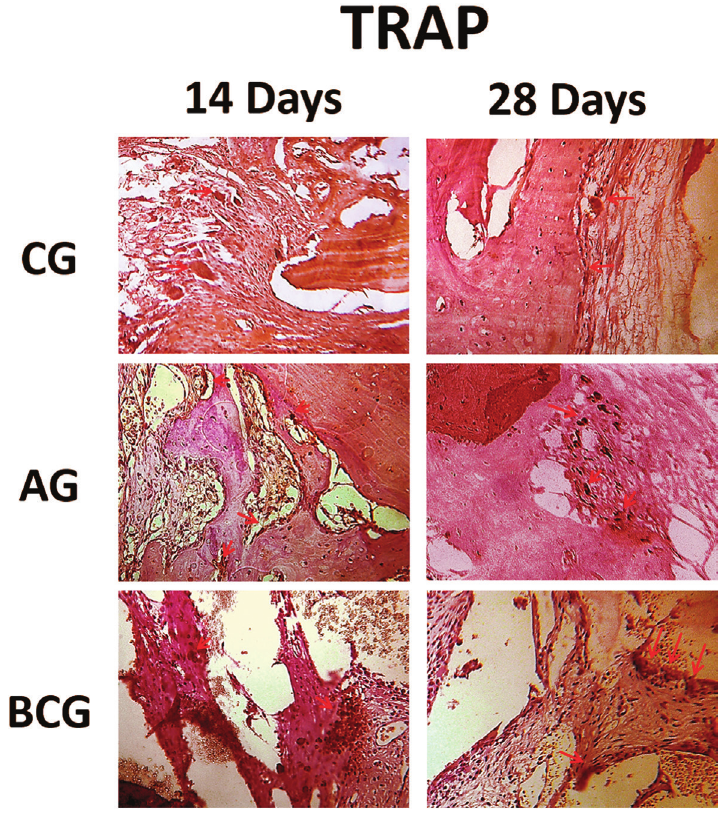
Figure 7- TRAP immunostaining at 14 days for the experimental groups (CG: light; AG: moderate; BCG: light) and at 28 days (CG: light; AG: light; BCG: moderate). Immunolabeling indicated by red